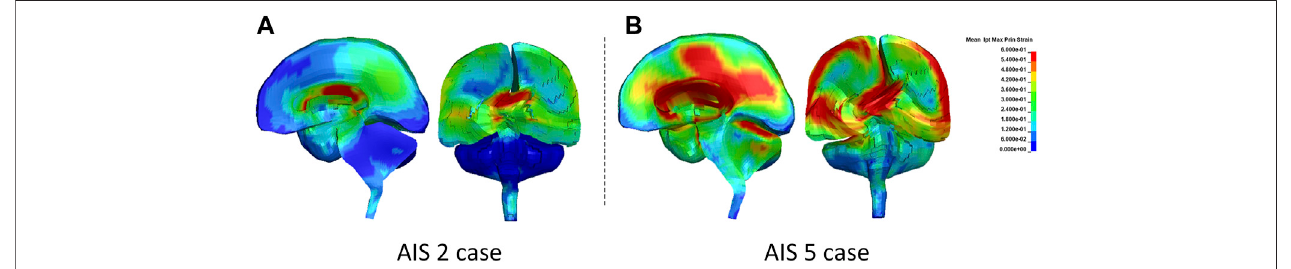
FIGURE 11 | The MPS contour in the sagittal and coronal sections of the brain at the time when the highest MPS occurred: (A) AIS 2 case and (B) AIS5 case.